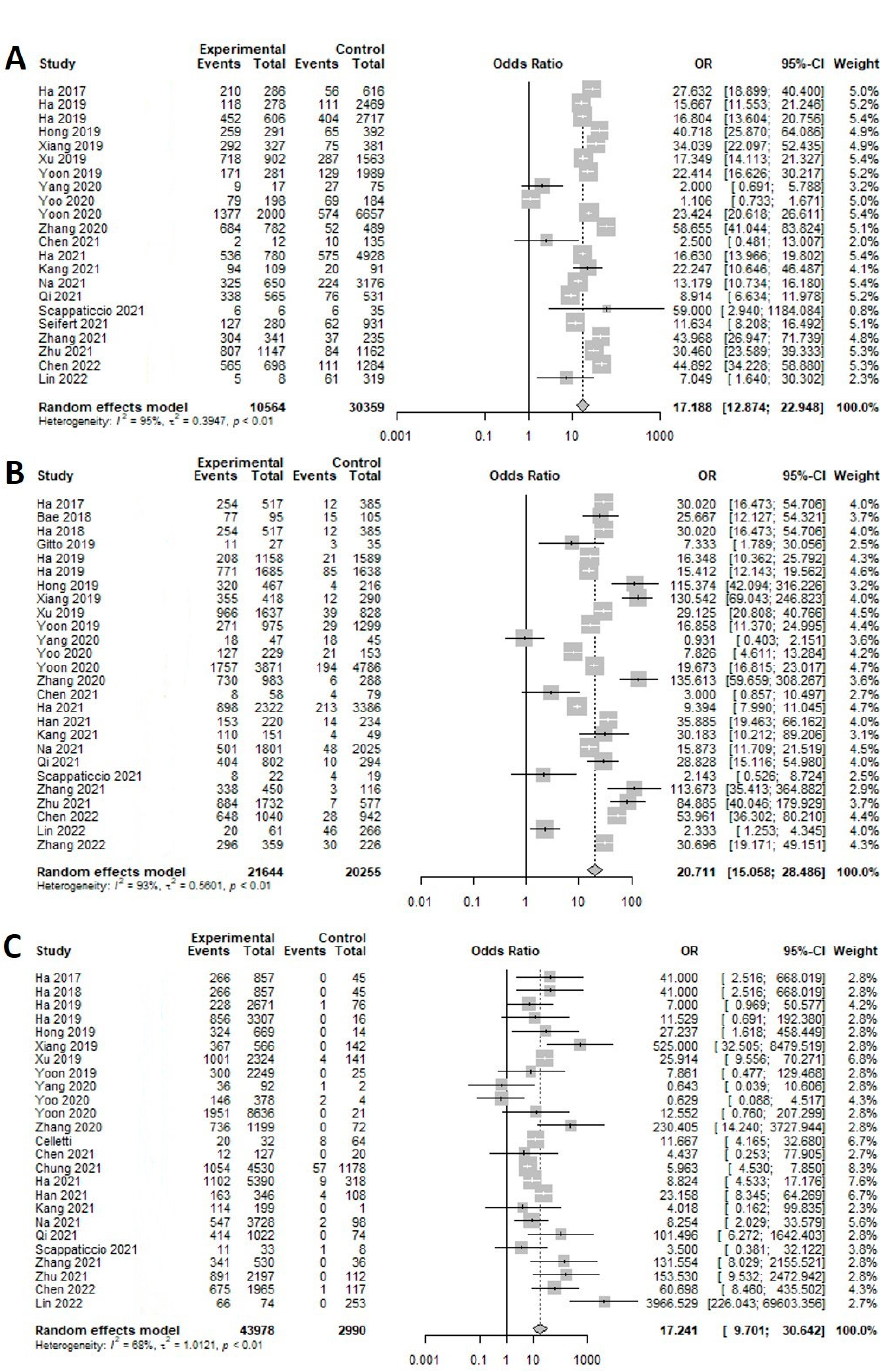
Figure 2. Forest plot of the diagnostic odds ratio for K-TIRAD. ( A ) High (K-TIRADS 5), ( B ) interme- diate (K-TIRADS 4), ( C ) low (K-TIRADS 3) .